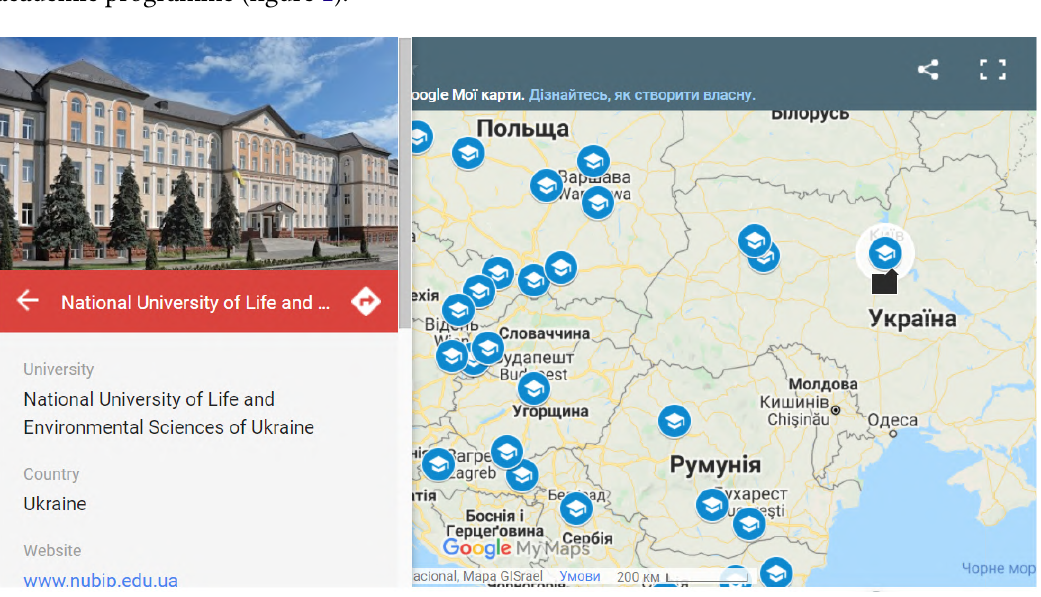
Figure 2: Marking on the Memsource cloud system website that the licence has been